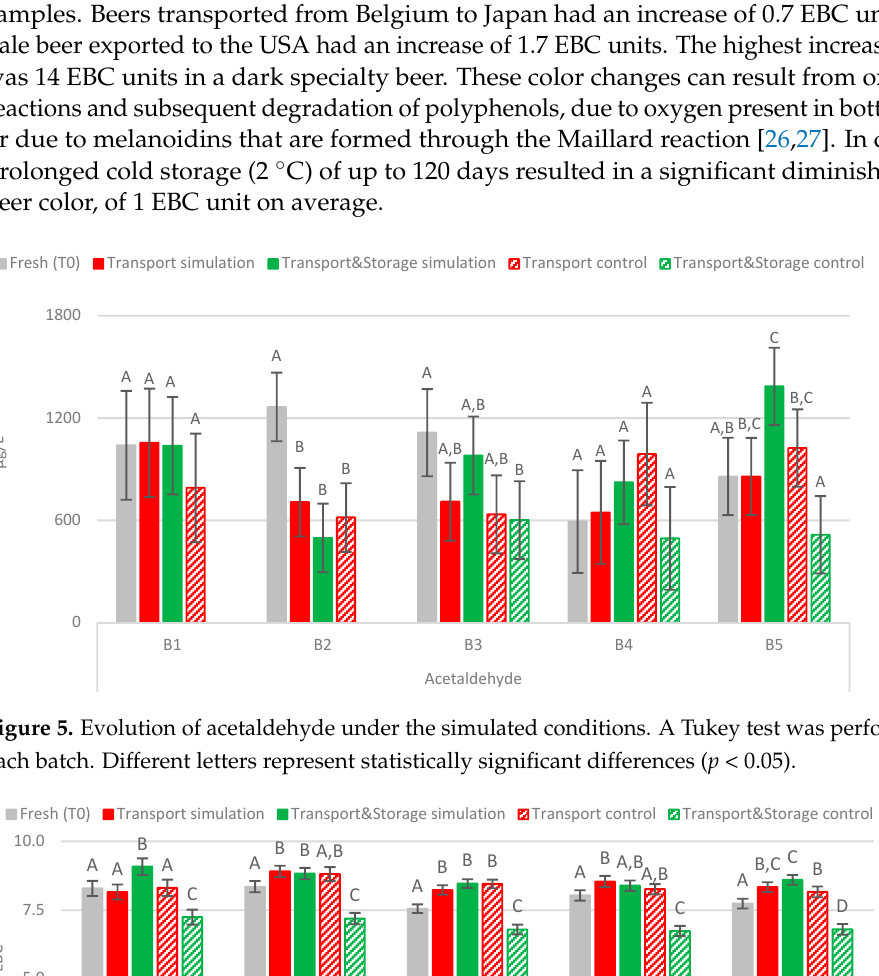
Figure 4. Evolution of 5-hydroxymethylfurfural under simulated conditions. A Tukey test was per- formed for each batch. Different letters represent statistically significant differences ( p < 0.05).